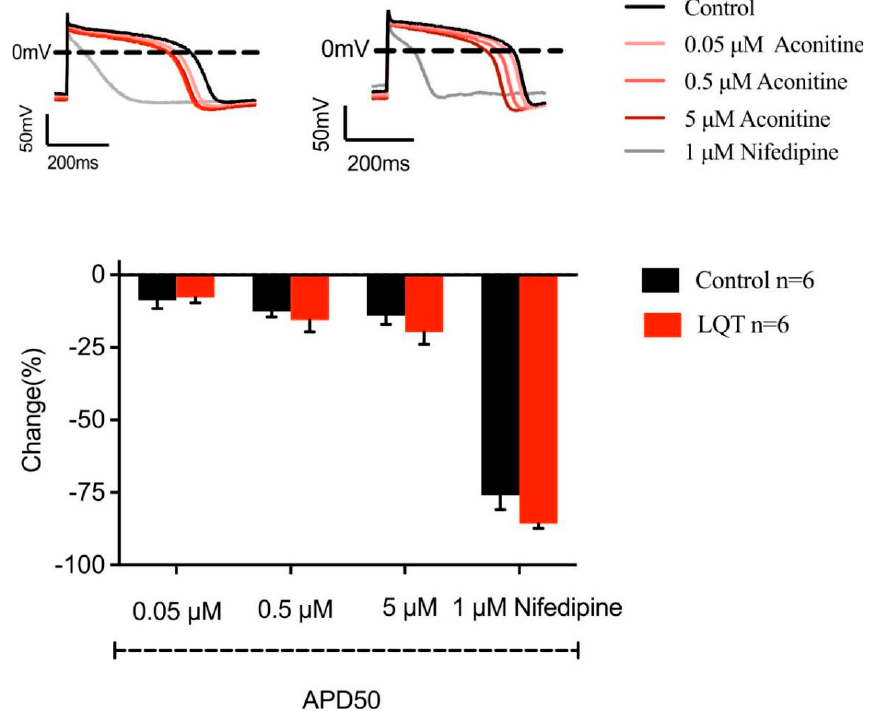
Figure 7. Effects of AC on action potentials of hiPSC-CMs. Panel A shows an overlay of single action potentials from a representative cell from a control hiPSC-CMs and from a long-QT syndrome (LQTS) hiPSC-CMs at a 1 Hz stimulation rate before (basal) and after application of 0.05 μ M–5 μ M AC. The bar graph represents the percent change induced by 0.05 μ M–5 μ M AC and 1 μ M nifedipine on action potential duration (APD) at 50% repolarization (APD50). Data are means ± SEM for 6 cells in each group (the control subjects and LQTS subjects) (Black: normal; Red: LQTS). 2.5. Effects of AC on Calcium Transients in Normal and LQT Syndrome hiPSC-CMs